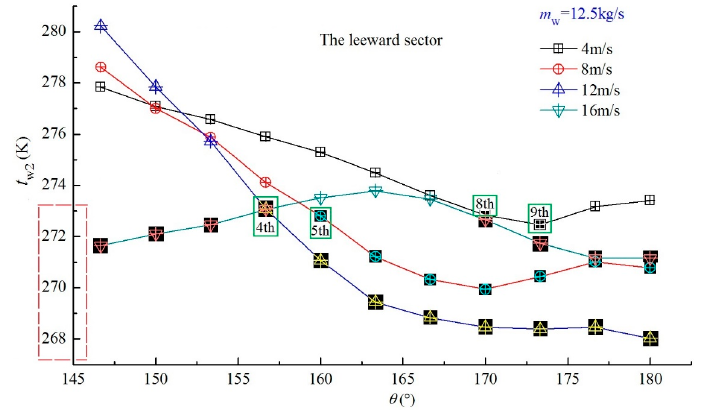
Figure 9. Outlet water temperature of each delta in rear sector with original flow rate of circulating water.